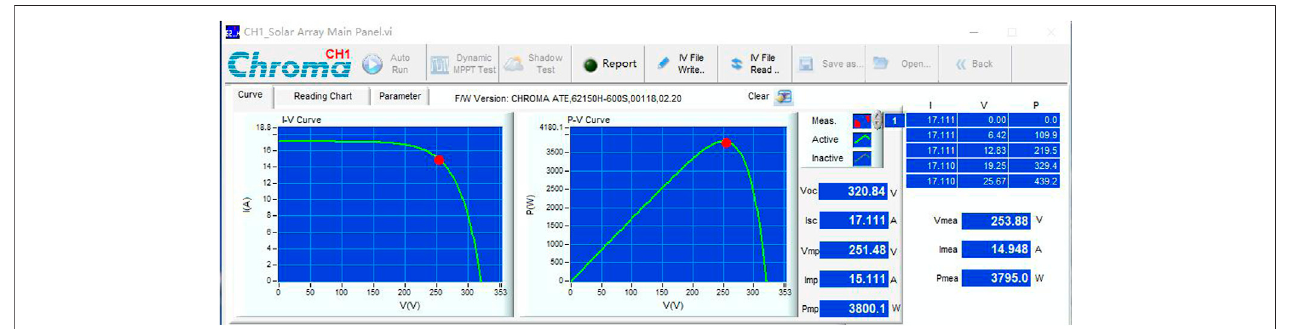
FIGURE 16 | Simulating the parallel-connected input mode experimental condition.